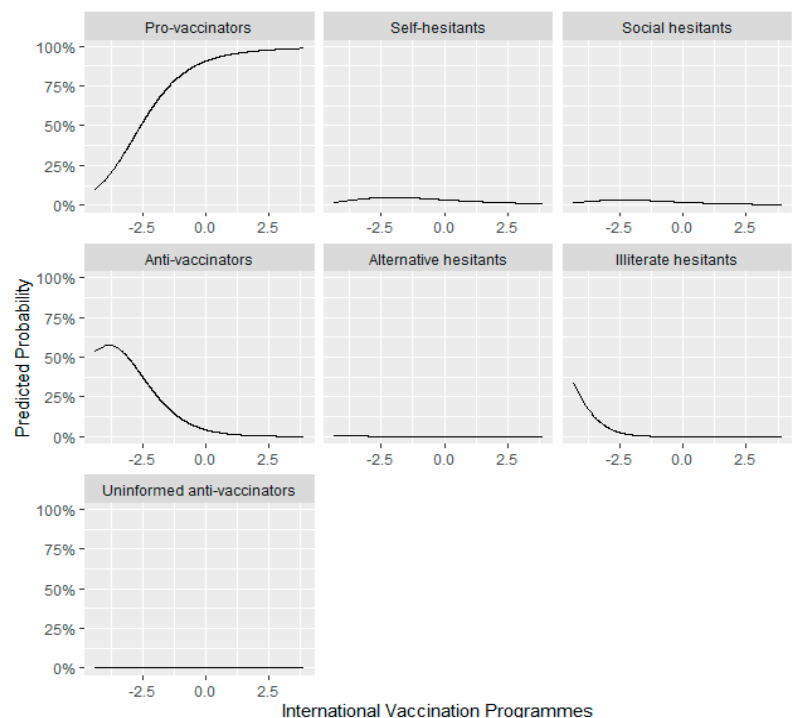
Figure A14. Marginal Effects Multinomial Logistic Regression. International Vaccination Programs.